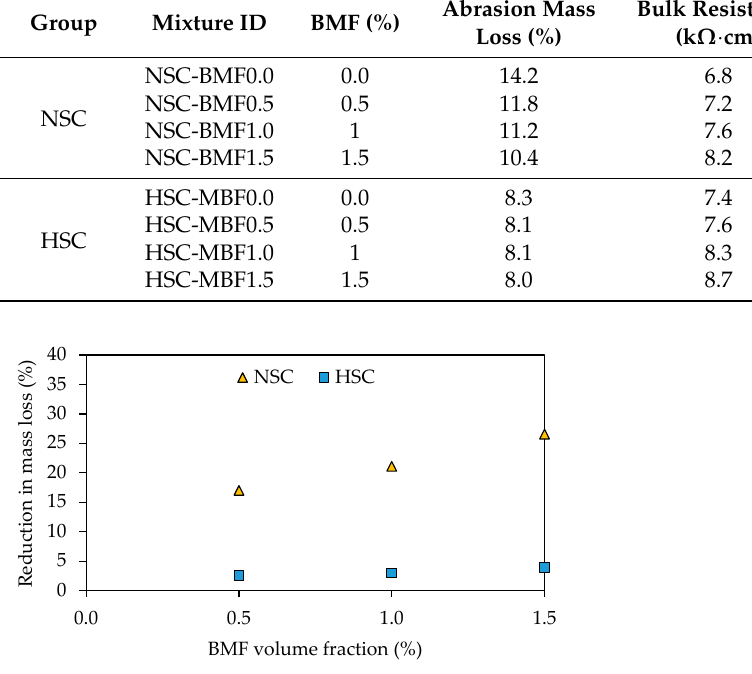
Figure 17. Reduction in abrasion mass loss versus BMF volume fraction relationship.